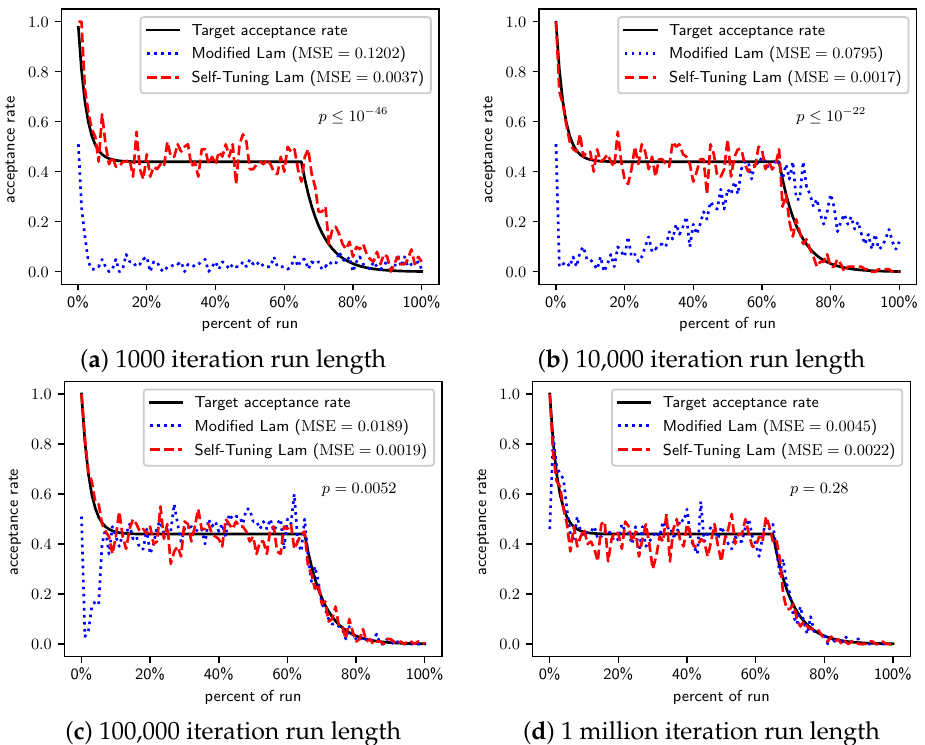
Figure 11. Minimize f 1,1000 ( x ) : Self-Tuning Lam, Modified Lam, and target acceptance rates for